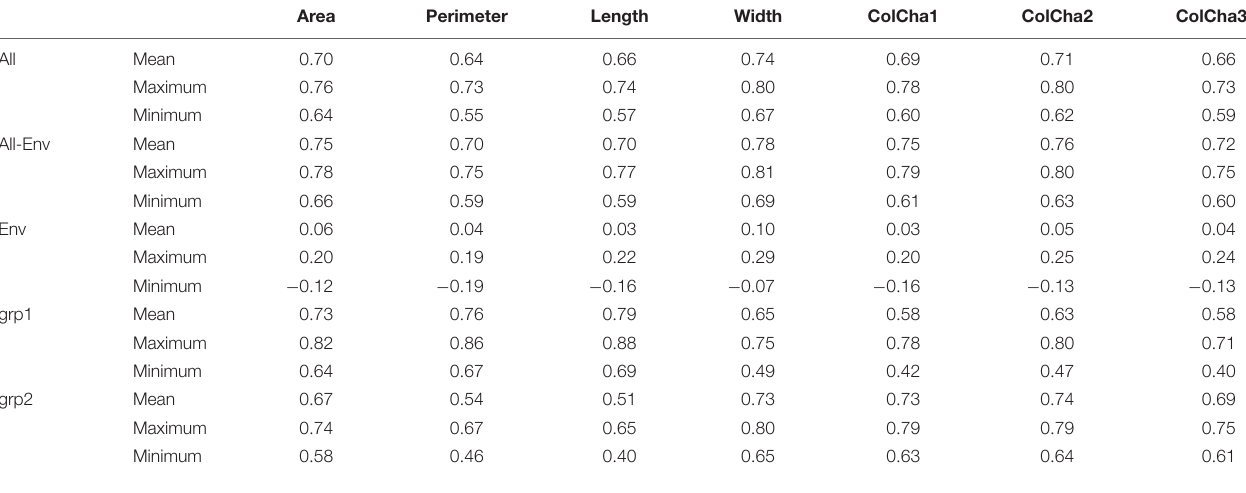
TABLE 2 | Prediction accuracies for grain traits using only markers (All), passport information (Env) and combining both (All + Env), and for separate subpopulations grp1 and grp2 of bread wheat landraces. Area Perimeter Length Width ColCha1 ColCha2